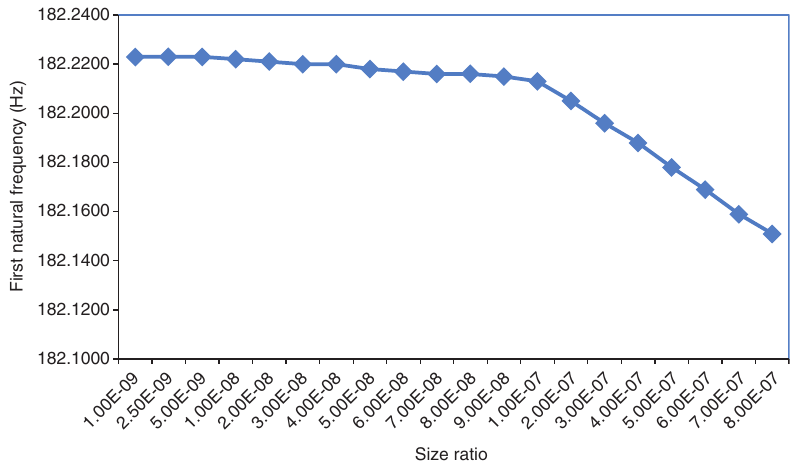
Figure 21: Variations of the first natural frequency of the simply supported beam with size ratio.